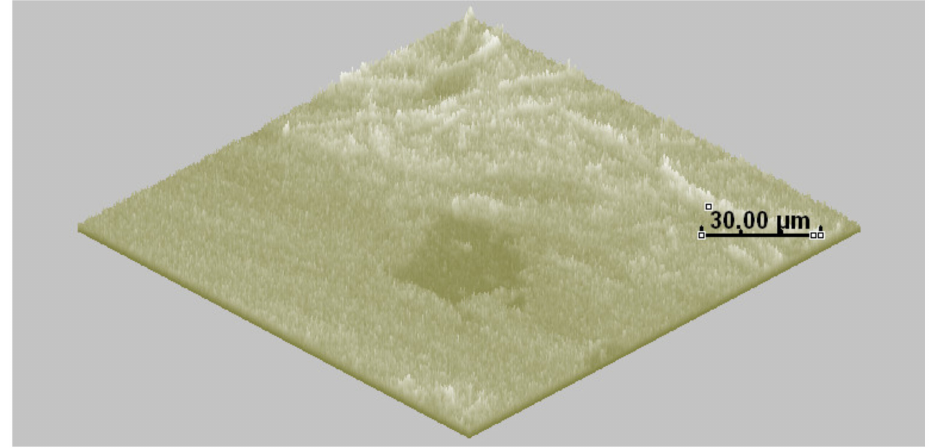
Figure 16. A 3D photo representing a segment being the channel made after the test with the visualization of an area with graphite